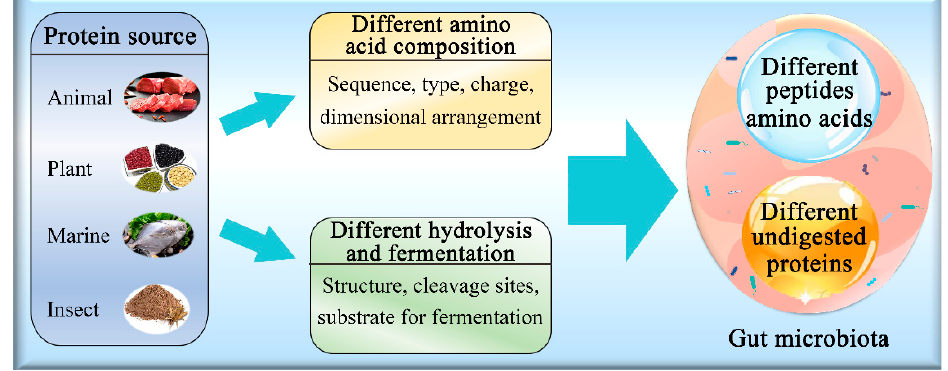
Figure 2. The effect of different protein sources on gut microbiota.